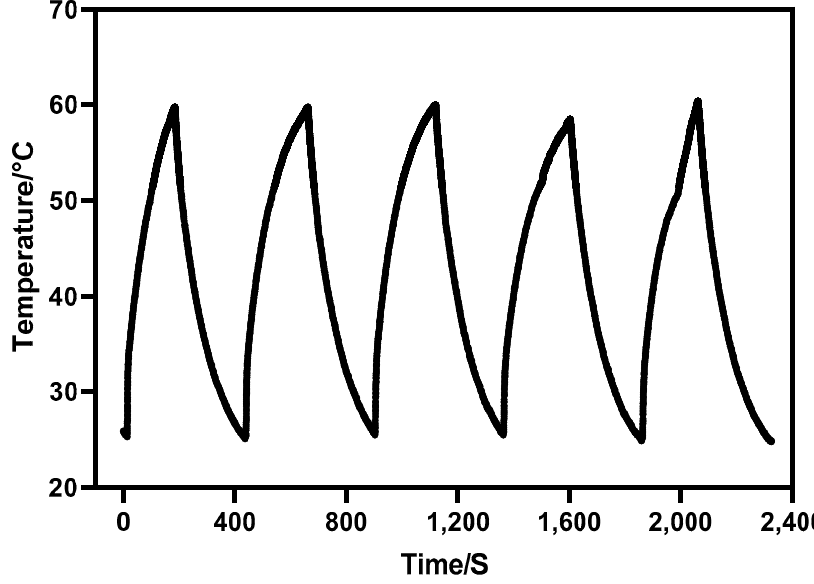
Figure 4. Temperature rise and drop cycle curve of 180 µ g/mL of Au-UCNPs (five times). The content of ROS released by different concentrations of Au-UCNPs-DSPE-PEG 2K under near-infrared light with a wavelength of 808 nm was measured by Singiet Oxygen Sensor Green (SOSG). As can be seen from Figure 5, Au-UCNPs-DSPE-PEG 2K hardly releases ROS without irradiation. The amount of ROS increased with the increase in Au-UCNPs-DSPE-PEG 2K concentration and time.